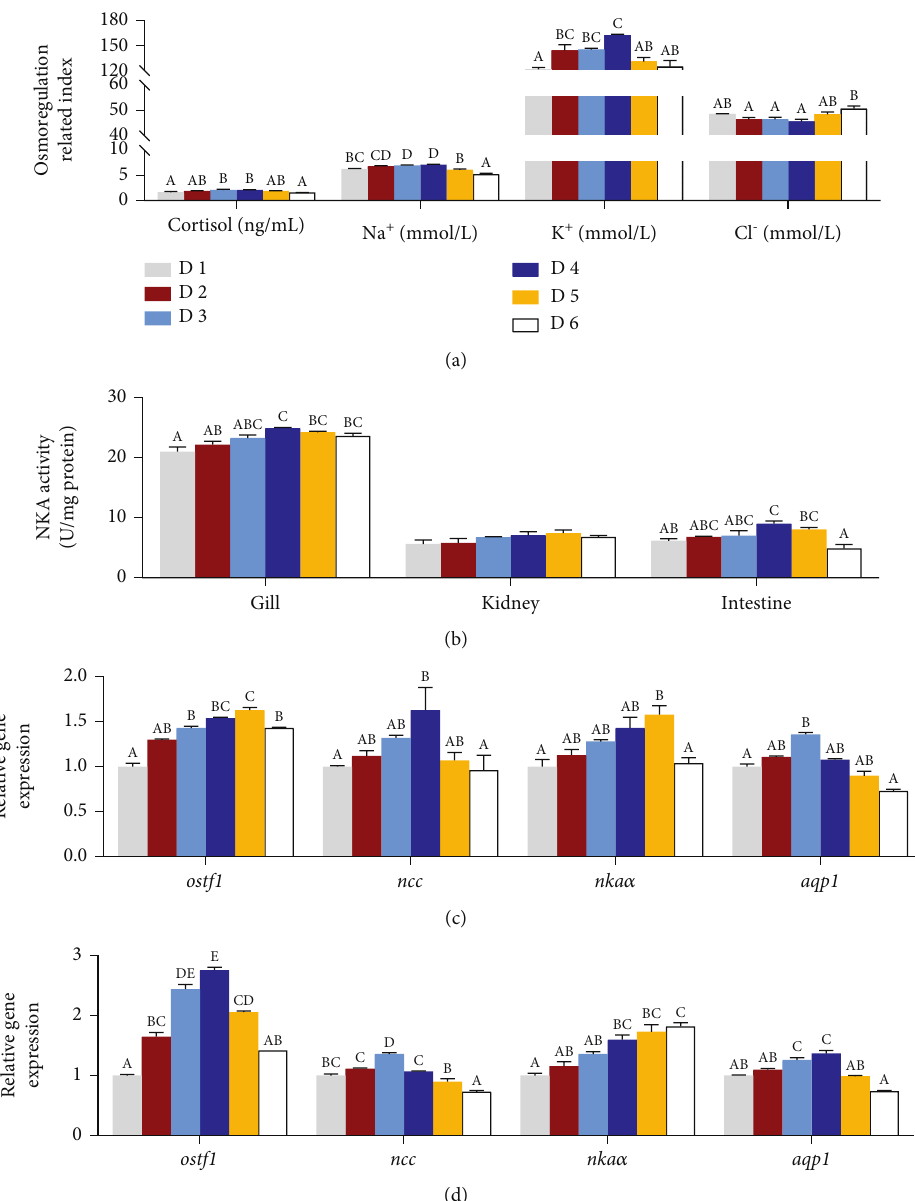
Figure 2: E ff ects of dietary lipid levels on osmoregulation ability of juvenile Acanthopagrus schlegelii reared at low-salinity water. Contents of serum cortisol and ions (a), NKA enzyme activity in the gill, kidney, and intestine (b), and expression levels of genes involved in osmoregulation in the gill (c) and intestine (d). The expression levels of target gene were calculated relative to the expression level of β - actin and then presented as relative to the expression level in the D1 group. Values are presented as means with standard errors represented by vertical bars ( mean ± SEM , n = 3 ). Mean values for the same column with di ff erent superscript letters were signi fi cantly di ff erent ( P < 0 : 05 ). aqp1 : aquaporin 1; ncc : Na + -Cl - cotransporter; nka α : Na + /K + -ATPase; ostf1 : osmotic stress transcription factor